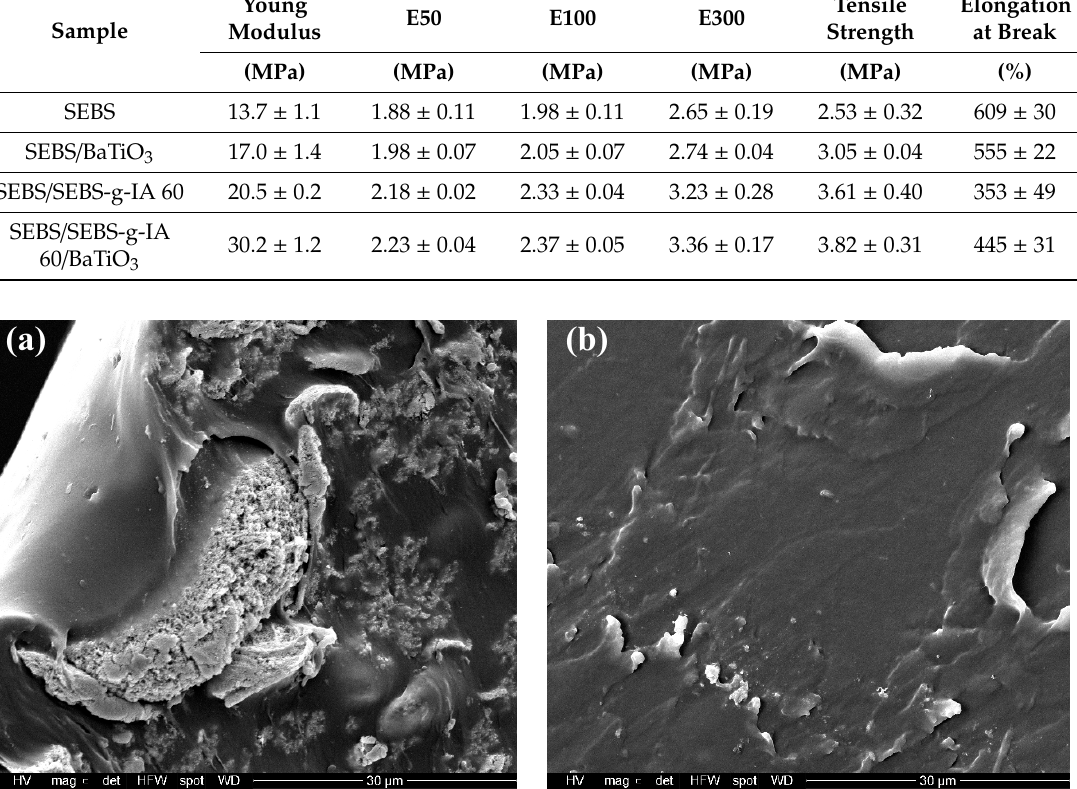
Table 3. Mechanical properties of SEBS/BaTiO 3 composites with and without SEBS-g-IA.